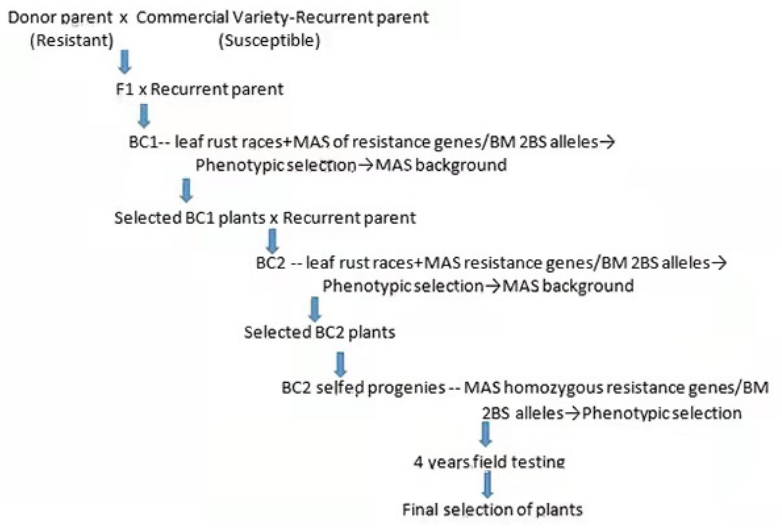
Figure 1. Scheme of introgressions.